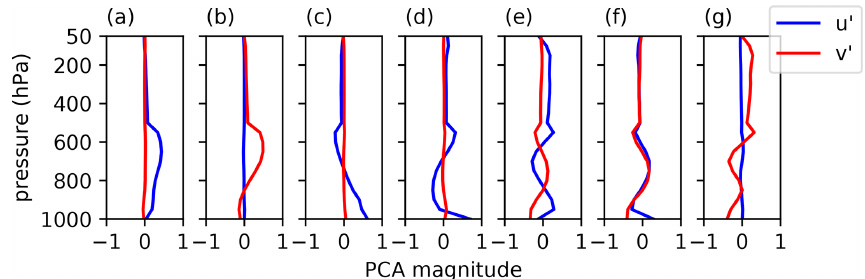
Figure 3. The first to the seventh principal component, shown in (a) to (g) respectively, as profiles of magnitudes between − 1 and 1, for both u (cid:48) and v (cid:48)